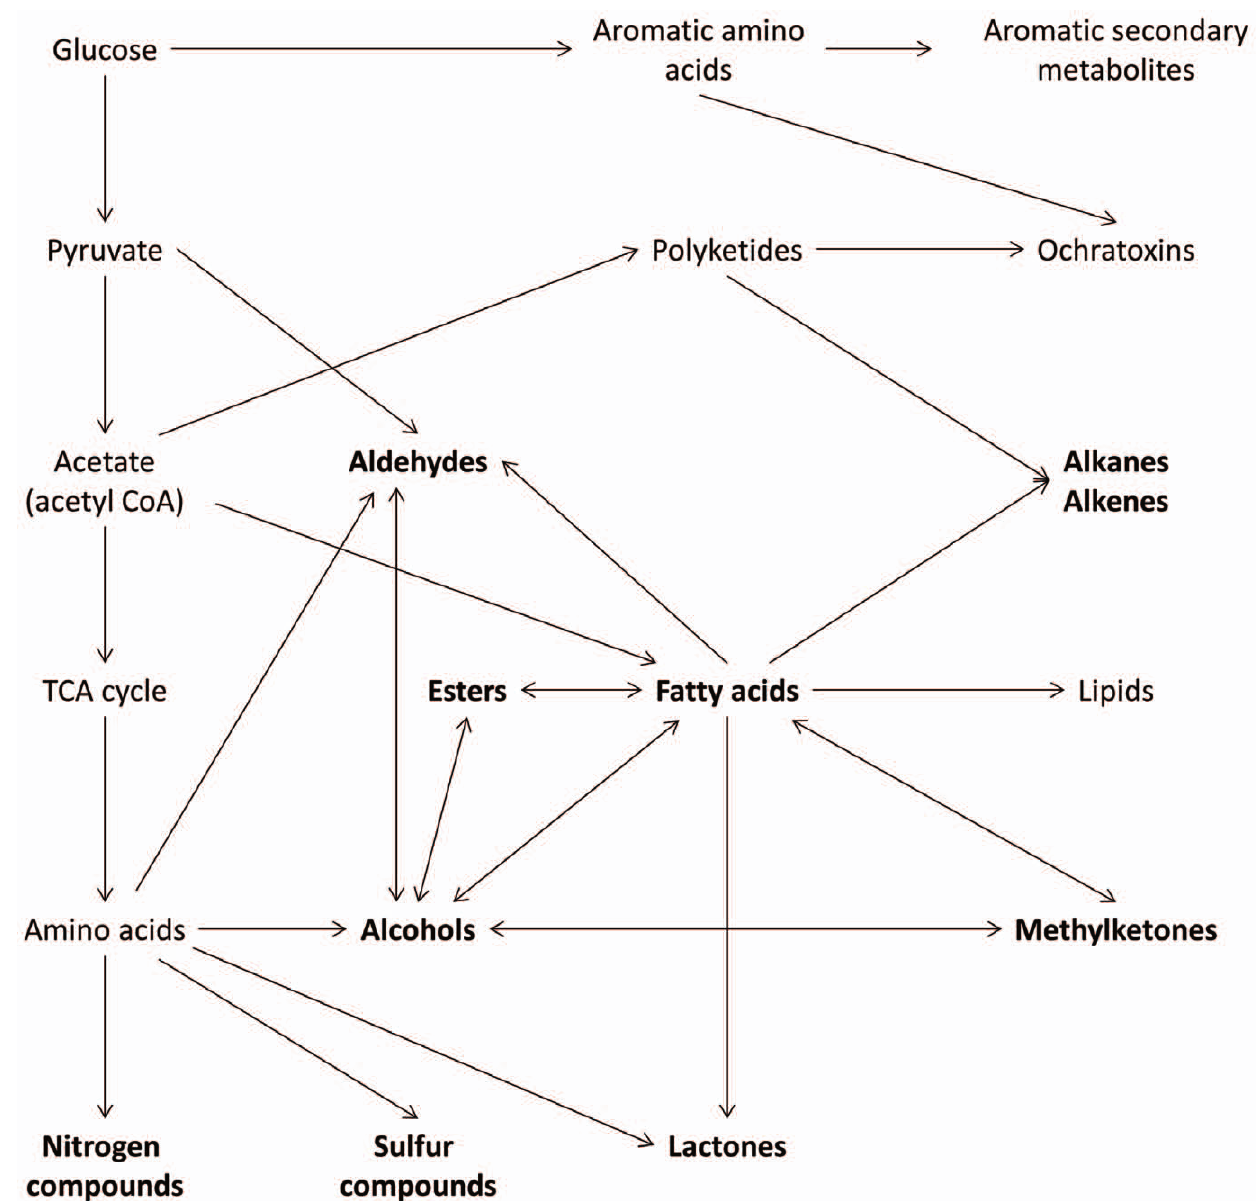
Figure 6. Main metabolic pathways for the production of microbial metabolites. VOC are shown in bold [52].